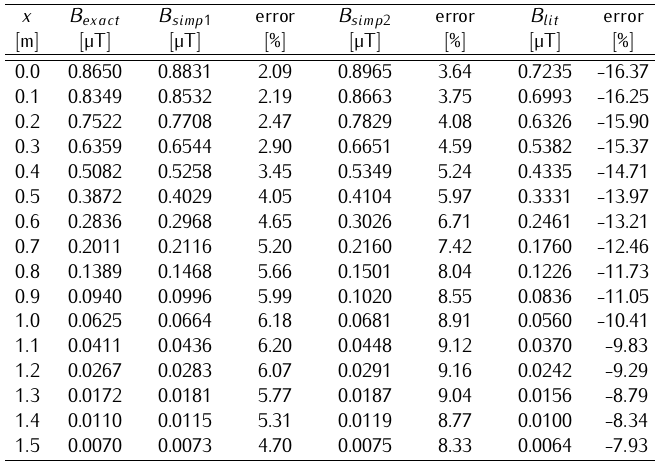
Table 2. B exact , B simp 1 , B simp 2 , B lit at ground level vs. distance x from the cable axis and relevant percent errors with respect to B exact for the cable